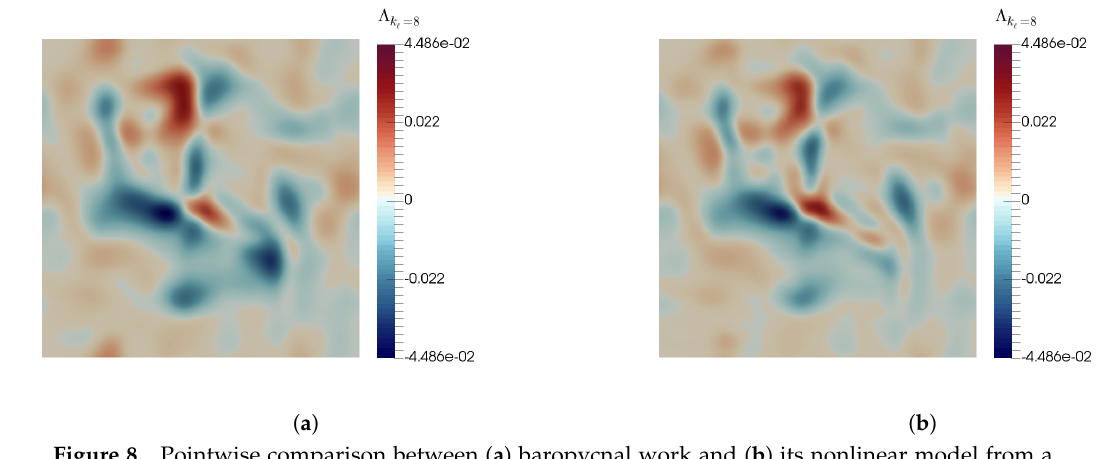
Figure 7. Same as in Figure 5 but using the sharp-spectral filter. The correlation coefficients are R c = 0.27 at filter scale k (cid:96) = 8 and R c = 0.28 at k (cid:96) = 16. The correlation between Λ and Λ m is poor when using a sharp-spectral filter due to its nonpositivity, which can yield negative filtered densities [15] and physically unrealizable stresses [46].